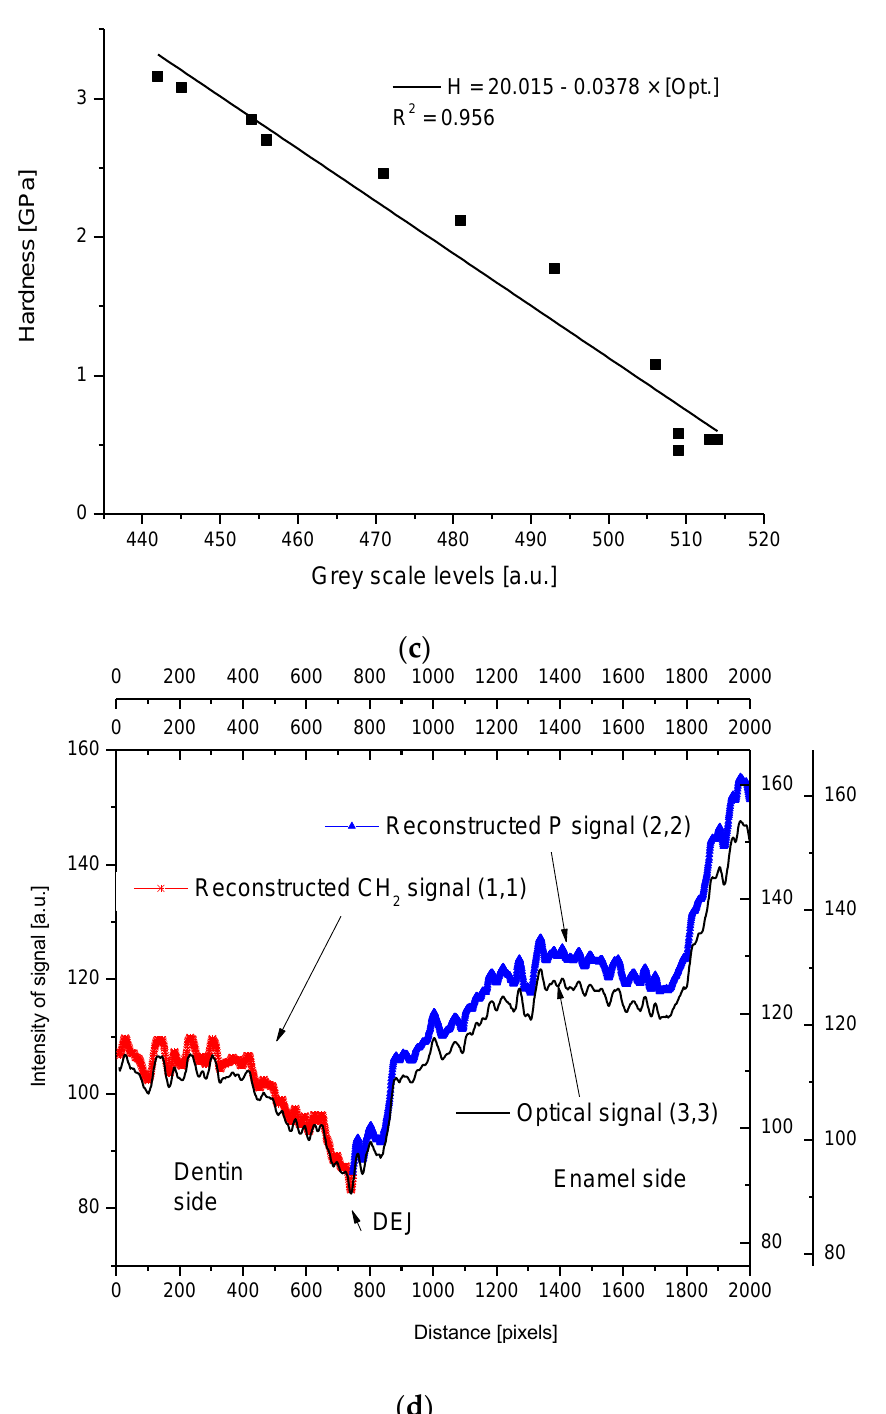
Figure 7. ( a ) Correlation between the drop in the phosphor concentration (EPMA) and the hardness, with the perfect linear fit to the points (P concentration from our studies, hardness adopted from Marshall et al., [12], as tailored in Figure 4). ( b ) Correlation between the increase in the CH 2 concentration from Raman measurements and the friction coefficient (data from Marshall et al. [12]), recalculated and combined by us). ( c ) Correlation between hardness and optical signal. ( d ) Reconstruction of the DEJ from chemical signals transformed into optical signals using the relevant correlations and its comparison with the real optical signal.